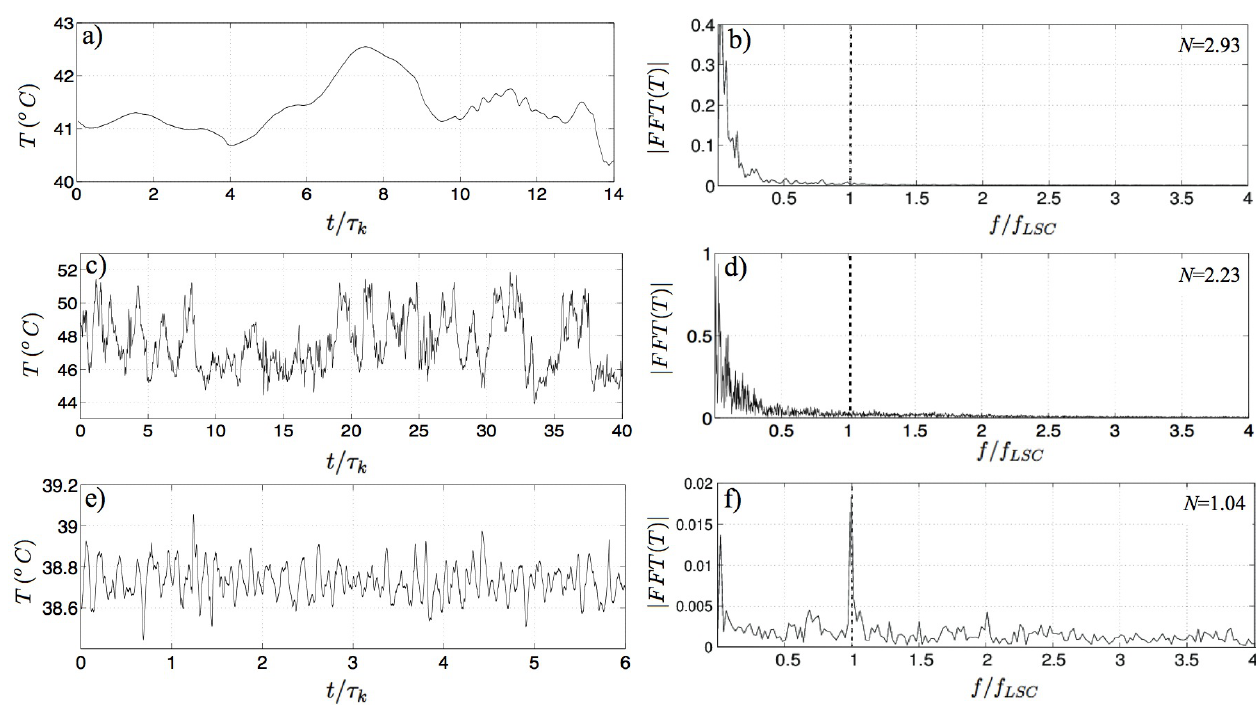
Figure 14. Central thermistor T temperature time series (left column) and Fourier 3 spectra (right column) from laboratory magnetoconvection experimental cases ( a , b ) MC 1 ; and ( e , f ) Ra = 2 . 96 × 10 5 (Table 5). The spectral plots show that the magnetically ( c , d ) MC 2 l damped cases with N > 2 have little power at f = f . However, in the Ra = 2 . 96 × 10 5 LSC case, the magnetic damping no longer dominates and the spectrum peaks at the inertial frequency f = f LSC